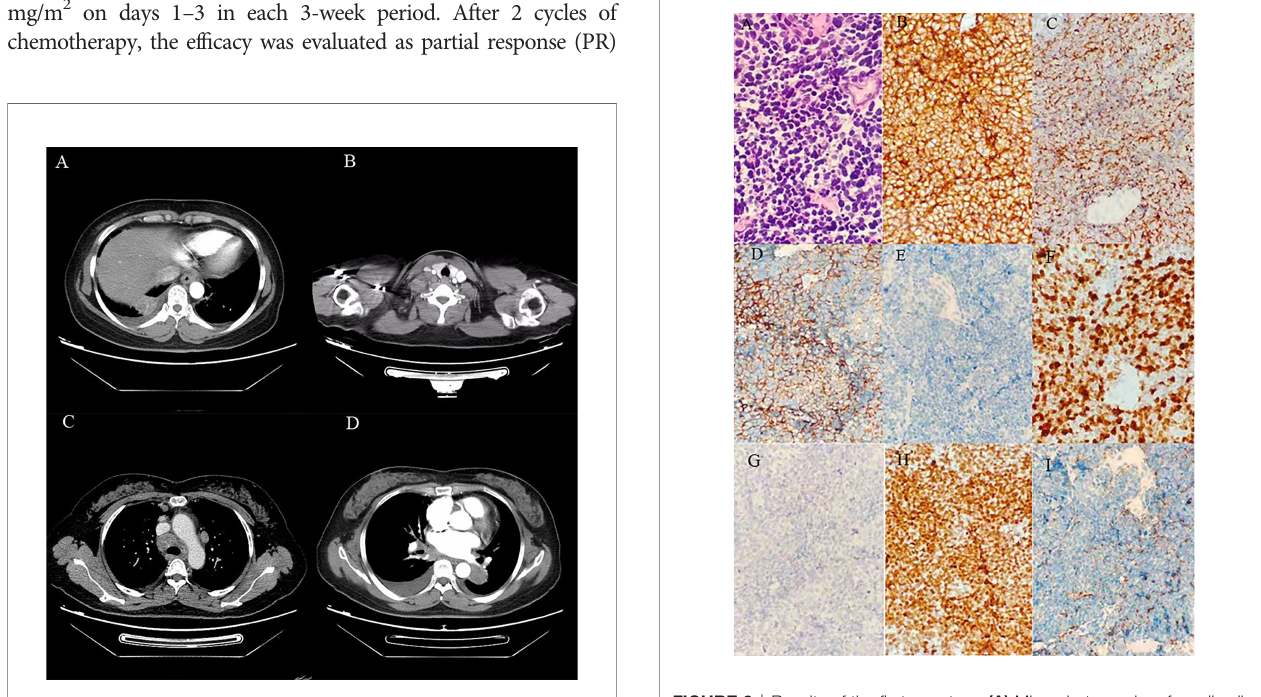
FIGURE 1 | Chest CT of the patient before treatment: (A – D) show the range of lesions, respectively.